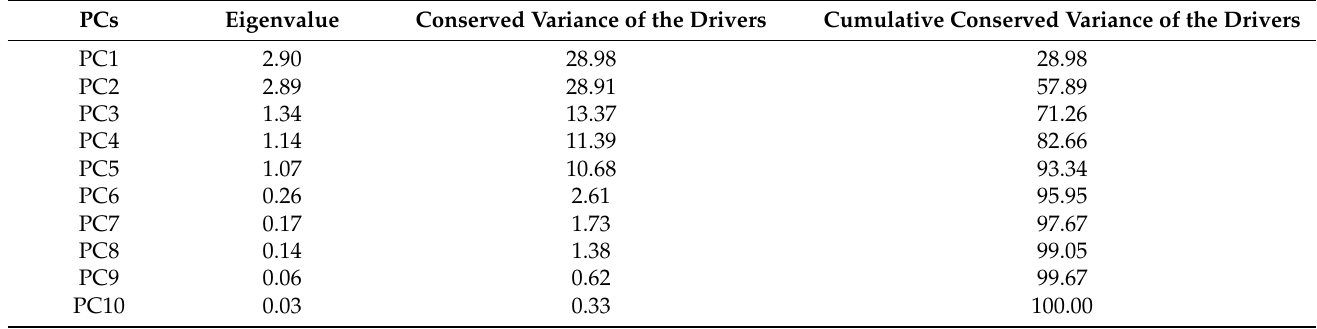
Table 1. General characteristics of the calculated principal components (PCs). Cumulative Conserved Variance of the